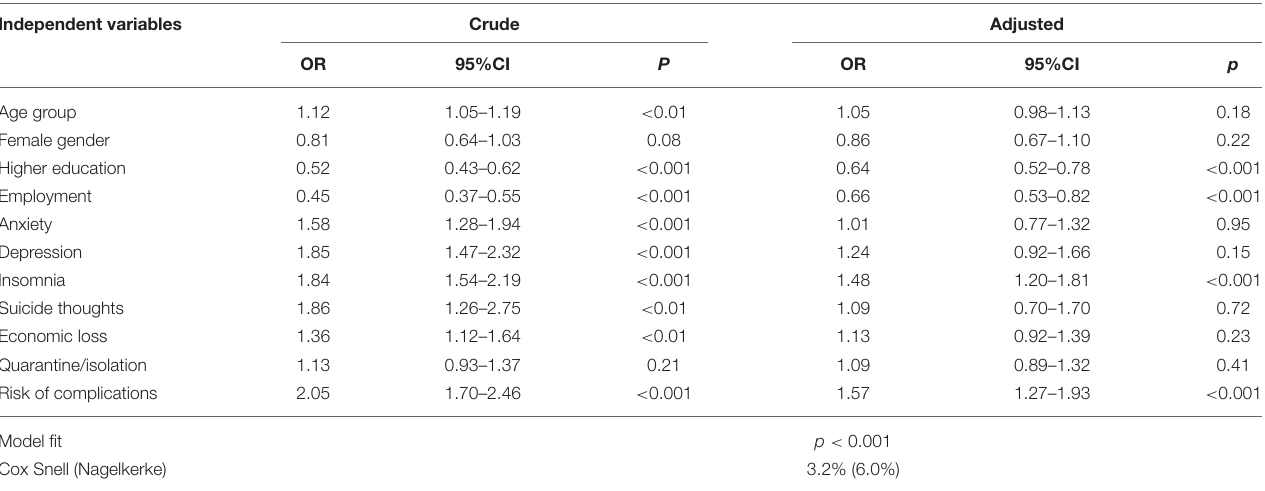
TABLE 5 | Associations with use of